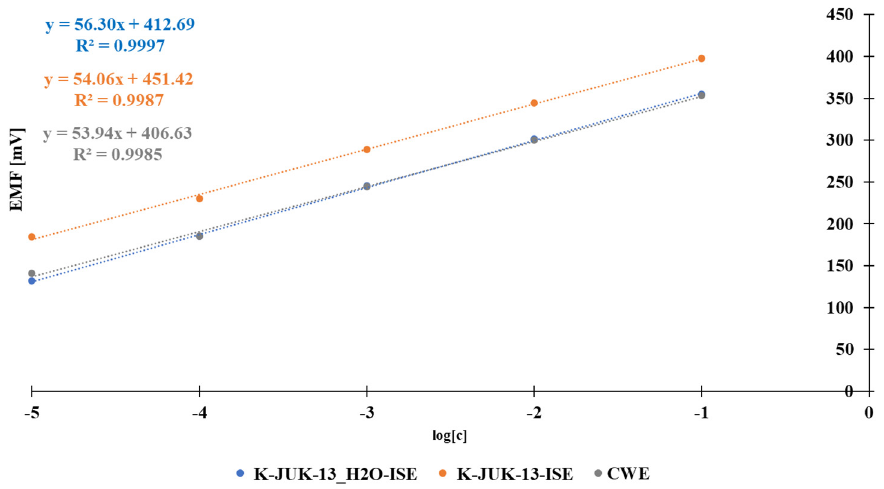
Figure 1. Calibration graphs for the constructed electrodes with MOFs as solid contact and CW electrode in the main ion concentration range 10 − 5 –10 − 1 mol L − 1